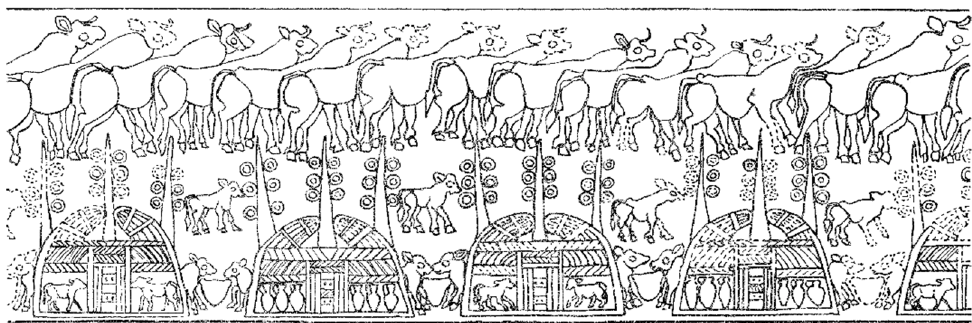
Figure 1. Seal impression depicting rows of cattle and reed huts (Adapted from ref. (Hamilton 1967, Figure 1)).